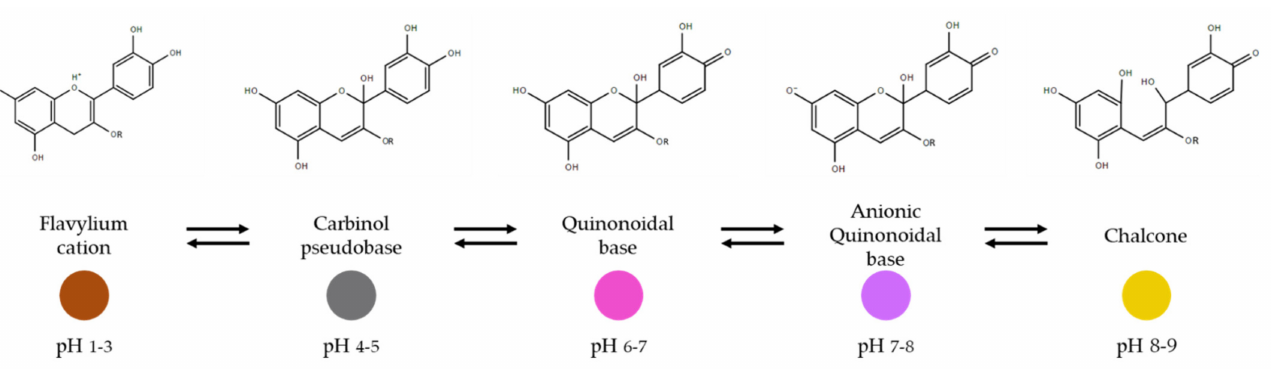
show colors going from light pink to colorless. From pH 7 to 12, anthocyanins change their color from light yellow-green to orange color. The color stability of anthocyanins was improved by using ZnO nanoparticles on the upper layer of the film, acting as a UV-light barrier. Additionally, the bilayer film is suited for electrochemical writing. To monitor fish spoilage, crucian was placed in a box with a lid and a hole was made on it, and